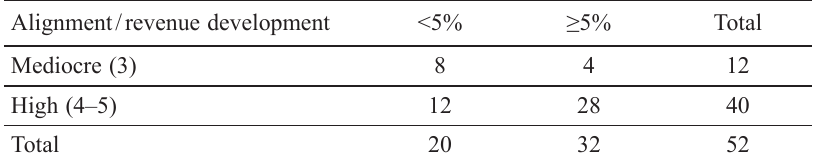
Table 2. Revenue development and alignment of business and information strategies Alignment / revenue